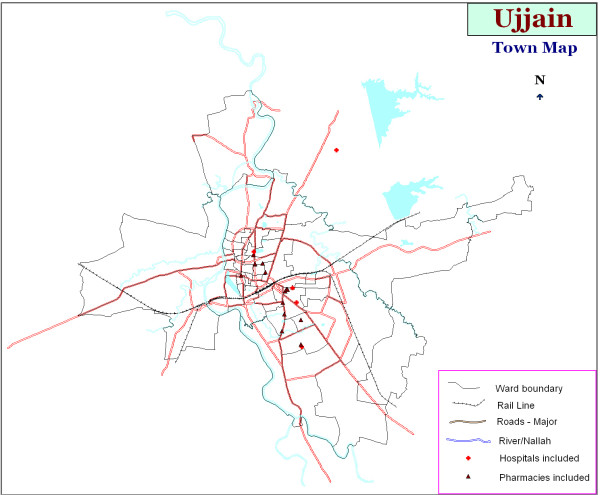
GIS map of Ujjain city showing the participating pharmacies and hospitals